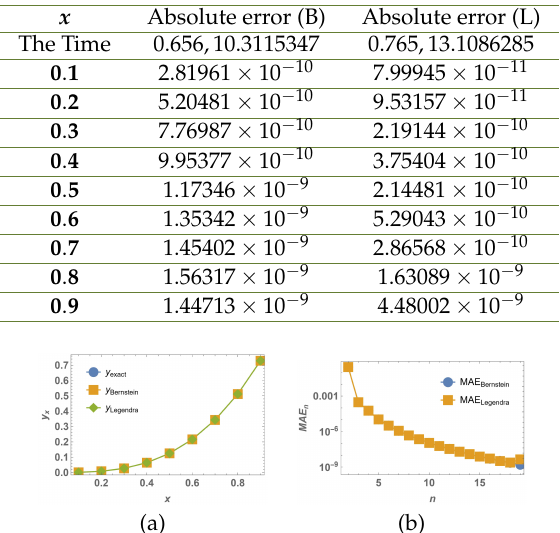
(cid:12) (cid:12) of